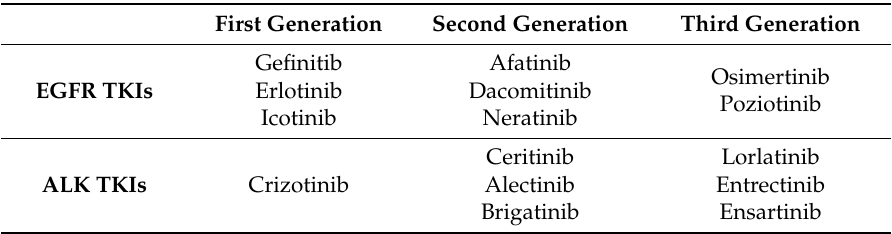
Table 1. Tyrosine kinase inhibitors (TKIs) in non-small cell lung cancer. EGFR: epidermal growth factor receptor; ALK: anaplastic lymphoma